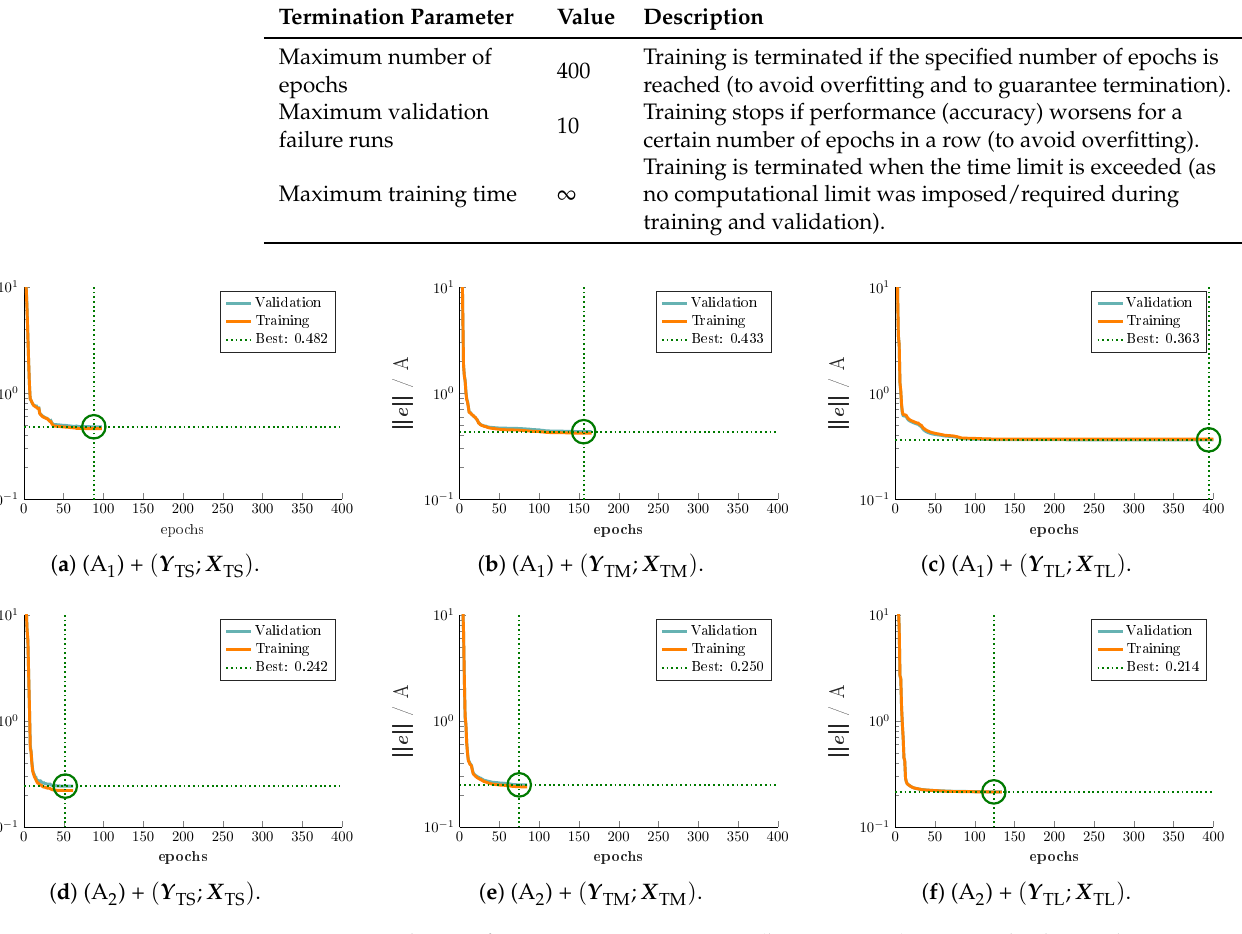
Figure 15. Evolution of approximation error norm (learning error) over epochs during the training of the ANN Architectures (A 1 ) & (A 2 ) with the small, medium and large training data sets ( Y TS ; X TS ) ( Y ) and ( Y ) , TM ; X TM TL ; X TL